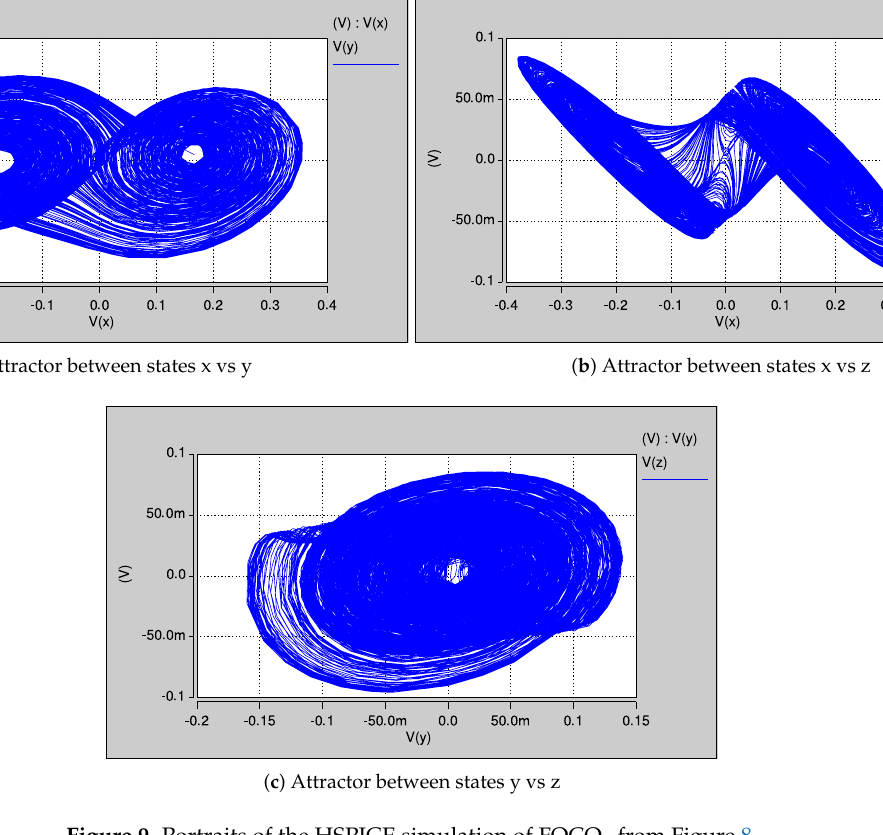
Figure 9. Portraits of the HSPICE simulation of FOCO 2 from Figure